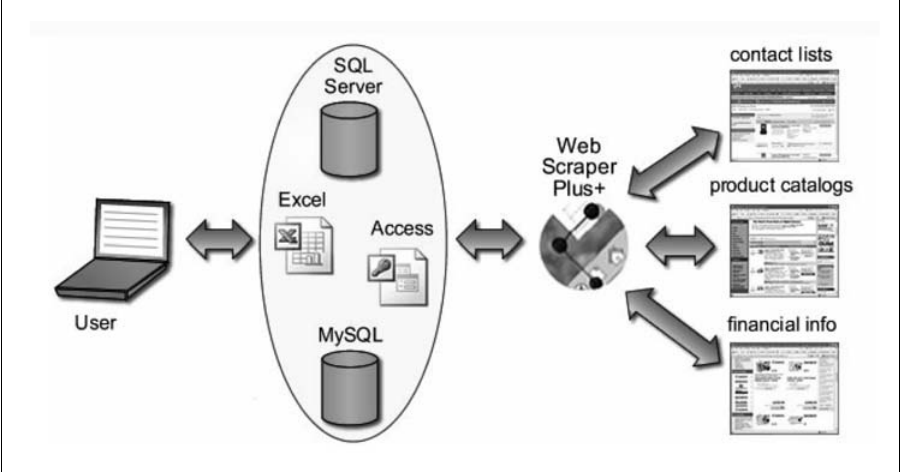
Fig 2. Data retrieval process with Web Scraper